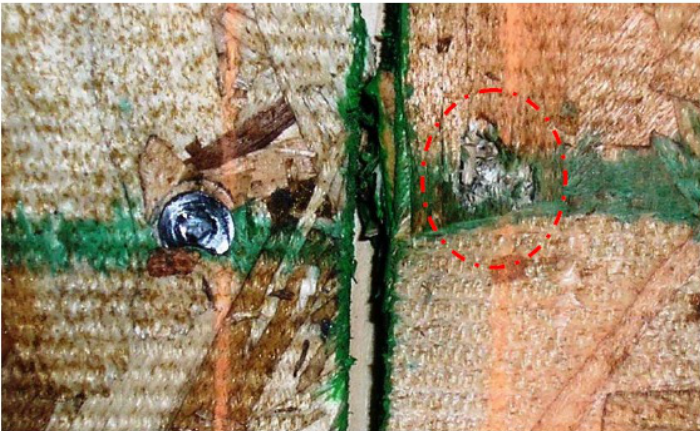
Figure 14. Nail pull-through along the center stud.